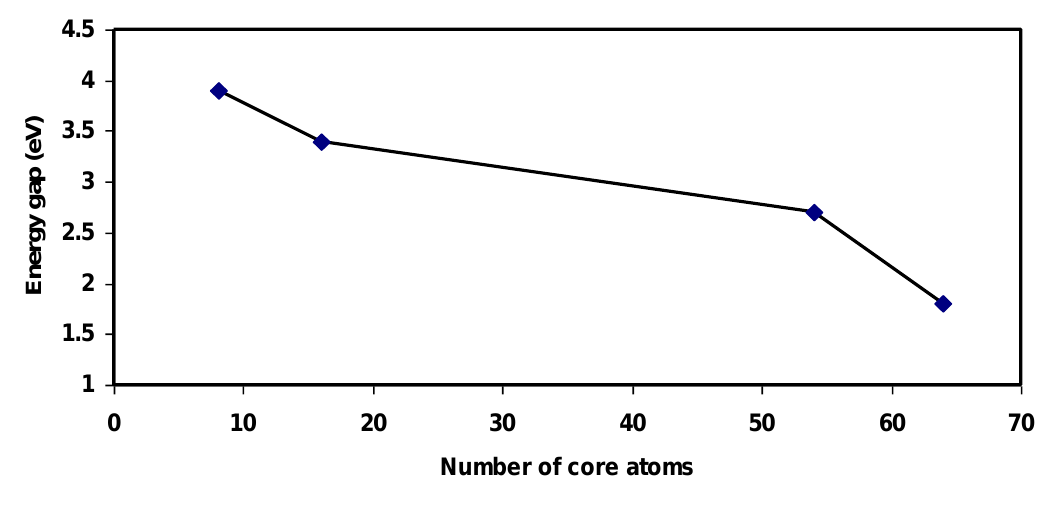
Fig. 6: Energy gap variation with the number of core LUC atoms of CdS